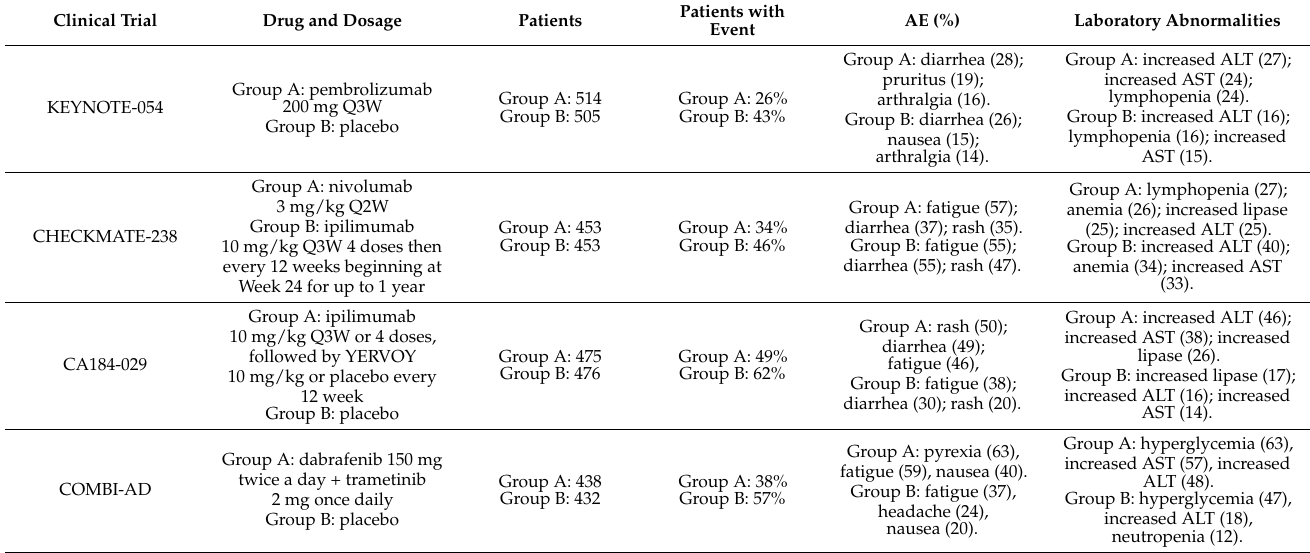
Table 2. Efficacy and safety of drugs currently approved as the adjuvant treatment of patients with melanoma and lymph node